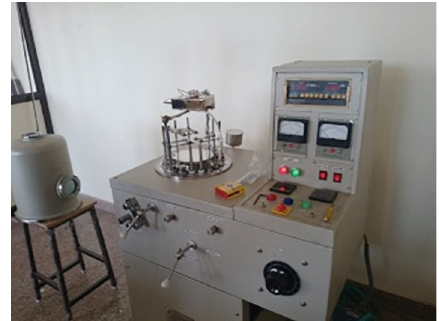
Figure 1: Thermal evaporation unit.